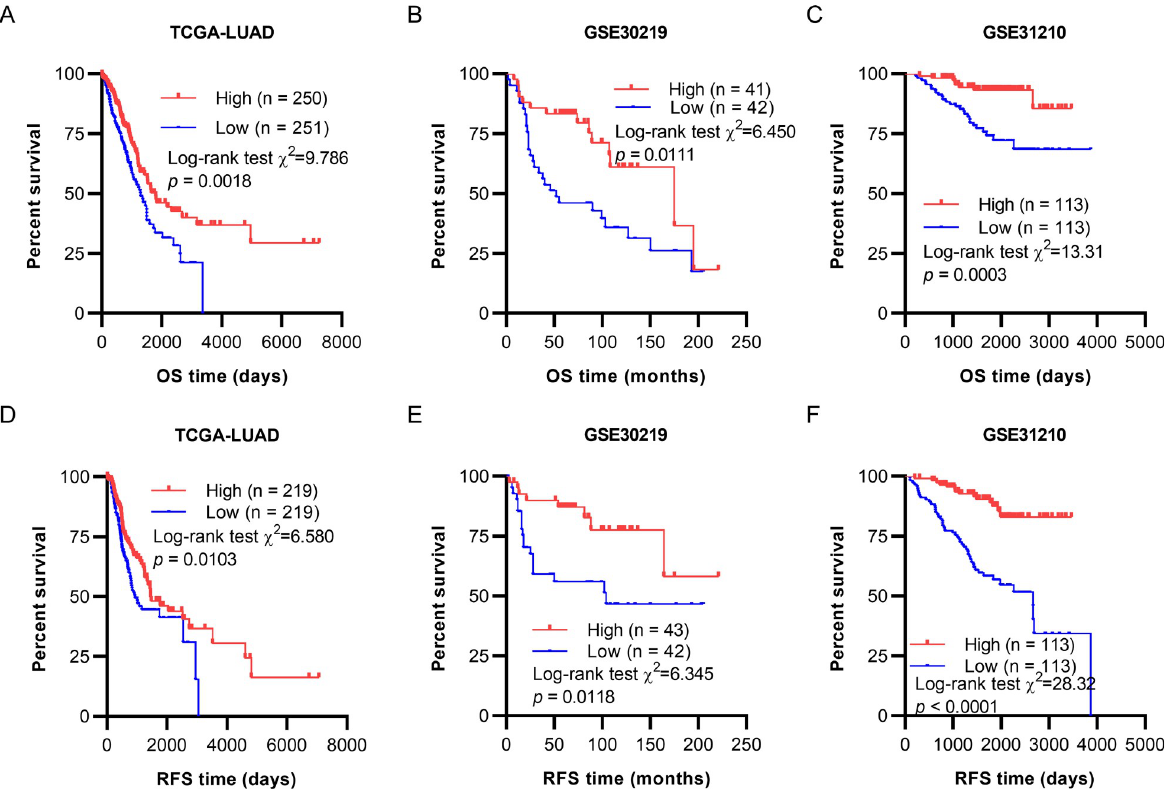
Fig 2. Low CYP4B1 expression was associated with unfavorable survival in patients with LUAD. (A–C) Kaplan-Meier curves of OS in patients with LUAD from a TCGA cohort (A), GSE30219 cohort (B) and GSE31210 cohort (C). (D-F) Kaplan-Meier curves of RFS in patients with LUAD from a TCGA cohort (D), GSE30219 cohort (E) and GSE31210 cohort (F). LUAD, lung adenocarcinoma; OS, overall survival; TCGA, The Cancer Genome Atlas; RFS, recurrence-free